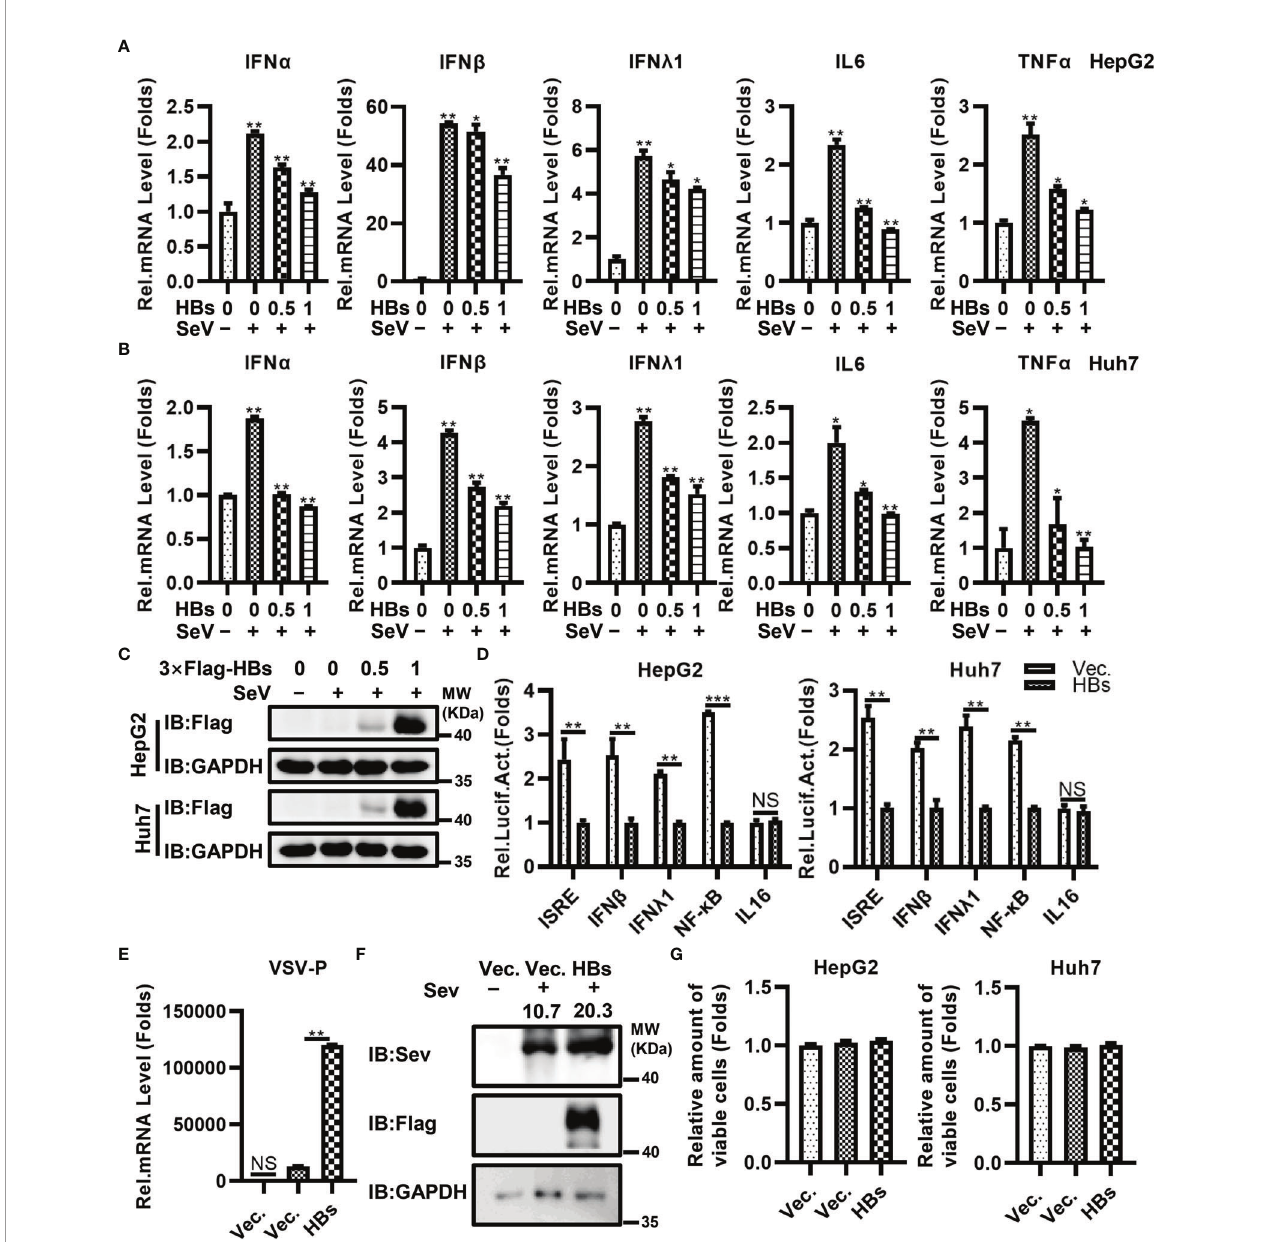
FIGURE 1 | HBsAg down-regulated the antiviral innate immune response in hepatic cells. (A) HepG2 cells and (B) Huh7 cells were transfected with different doses (0, 0, 0.5, 1 m g) of HBsAg (HBs) expression plasmids (3×Flag-HBsAg), the total amount of plasmids was adjusted to 1 m g with empty vector. At 24 h post- transfection, the cells were serum starved for 12 h. Cells were mock infected or infected with SeV (MOI = 1) for 12 h, and then harvested for qRT-PCR analysis. (C) HepG2 or Huh7 cells were transfected with different doses (0, 0, 0.5, 1 m g) of 3×Flag-HBs expression plasmids, the total amount of plasmids was adjusted to 1 m g with empty vector. At 24 h post-transfection, the cells were serum starved for 12 h. Cells were mock infected or infected with SeV (MOI = 1) for 12 h, and then harvested for western blots. (D) ISRE/IFN b /IFN l 1/NF- k B/IL16 luciferase reporter plasmids (0.3 m g) were co-transfected into HepG2 cells or Huh7 cells with HBs expression plasmids/vector plasmids (0.2 m g) and pRL-TK (0.1 m g). At 24 h post transfection, the cells were serum starved for 12 h. Next cells were infected with SeV (MOI = 1) for 12 h, and then harvested for luciferase activities determination. (E) HBs expression plasmids or vector plasmids (0.5 m g) were transfected into HepG2 cells. At 24 h after transfection, cells were mock infected or infected with vesicular stomatitis virus (VSV) (MOI = 1) for 12 h. The mRNA levels of VSV P protein were determined by qRT-PCR. (F) HBs expression plasmids or vector plasmids (1 m g) were transfected into HepG2 cells, at 24 h post-transfection, cells were mock infected or infected with SeV (MOI = 1) for 24 h, and then harvested for western blot. (G) HBs expression plasmids or vector plasmids (0.1 m g) were transfected into HepG2 cells and Huh7 cells. At 24 H post transfection, the cells were serum starved for 12 h. cells were infected with SeV (MOI = 1) for 12 h, and then conducted the MTT assays. All experiments were repeated three times with consistent results. The graphs show the means ± SD, n = 3 (***P < 0.01; **P < 0.01; *P < 0.05), NS., not signi fi